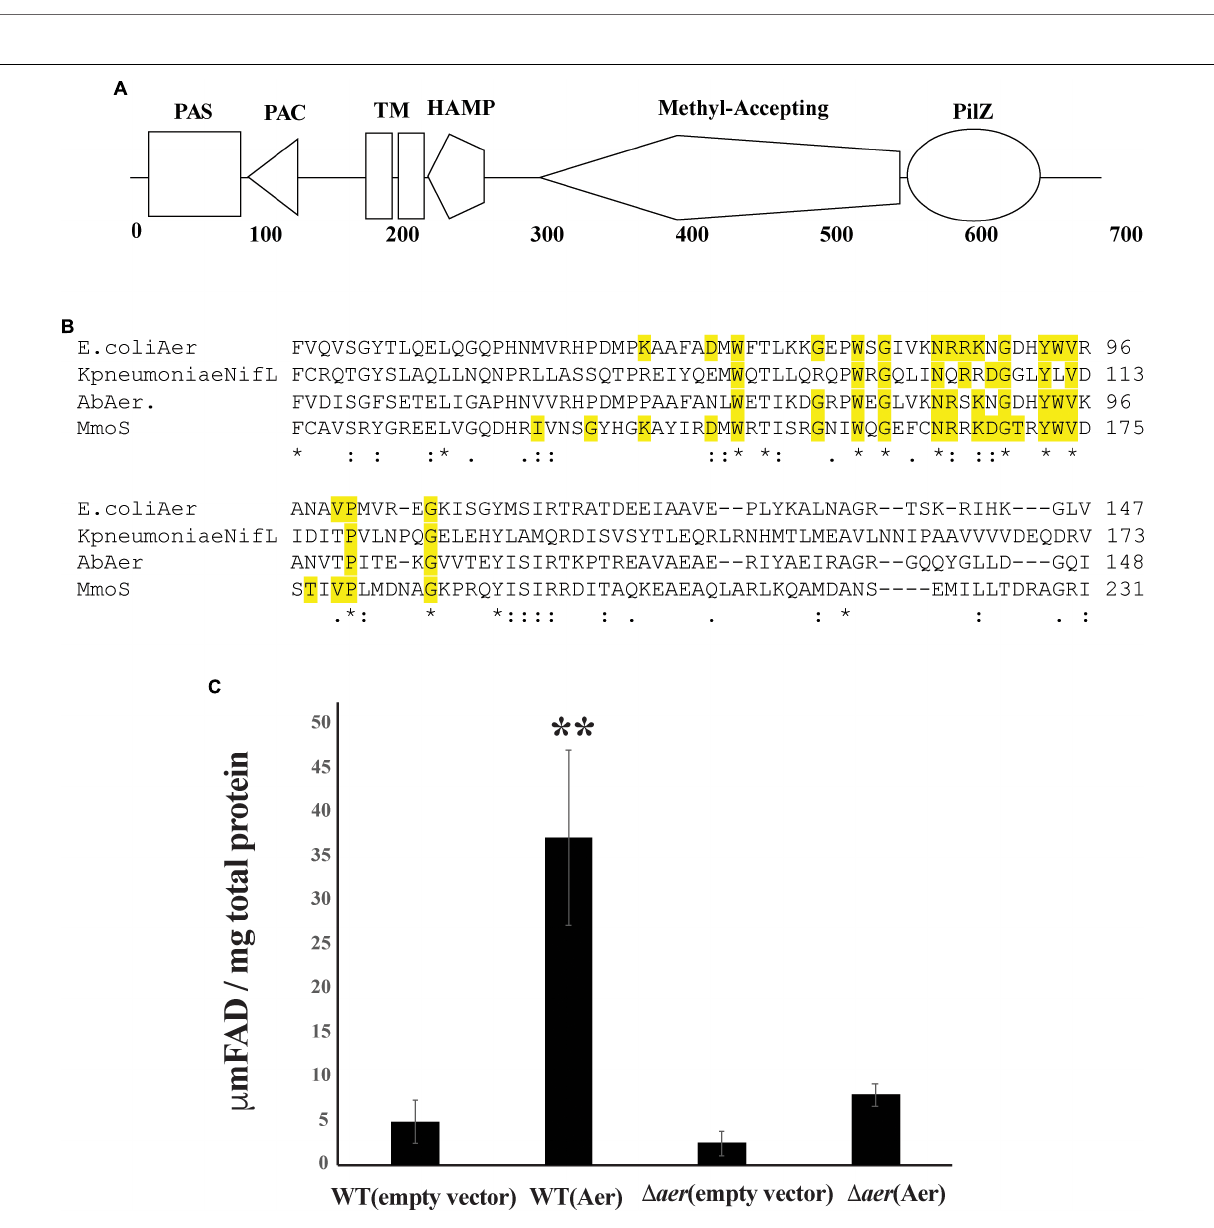
FIGURE 1 | The Aer protein domain organization. (A) Protein encoded by AZOBRv2_p280026 contains a PAS, PAC, Transmembrane domains, HAMP, MA, and PilZ domain. (B) Conserved residues alignment between AZOBRv2_p280026 (Aer) PAS domains binding FAD in E. coli Aer, Klebsiella pneumoniae NifL and Methylococcus capsulatus Mmos Below the sequence alignment, “ ∗ ” indicates positions with strictly conserved residues, “:” indicates position with strongly similar residues and “.” indicates positions with weakly similar residues. Yellow highlighted residues are those implicated in FAD binding (Schmitz, 1997; Bibikov et al., 2000; Ukaegbu and Rosenzweig, 2009). (C) Total cytosolic FAD for strains of A. brasilense overexpressing Aer. “ ∗∗ ” indicates statistically significant values ( p -value < 0.005) relative to the wild type strain. WT(empty vector) corresponds to the wild type strain carrying pRK415, WT(Aer) is the wild type strain carrying pRKAer, Daer(empty vector) is the (cid:49) aer mutant derivative carrying pRK415 and (cid:49) aer(Aer) is the (cid:49) aer mutant derivative carrying